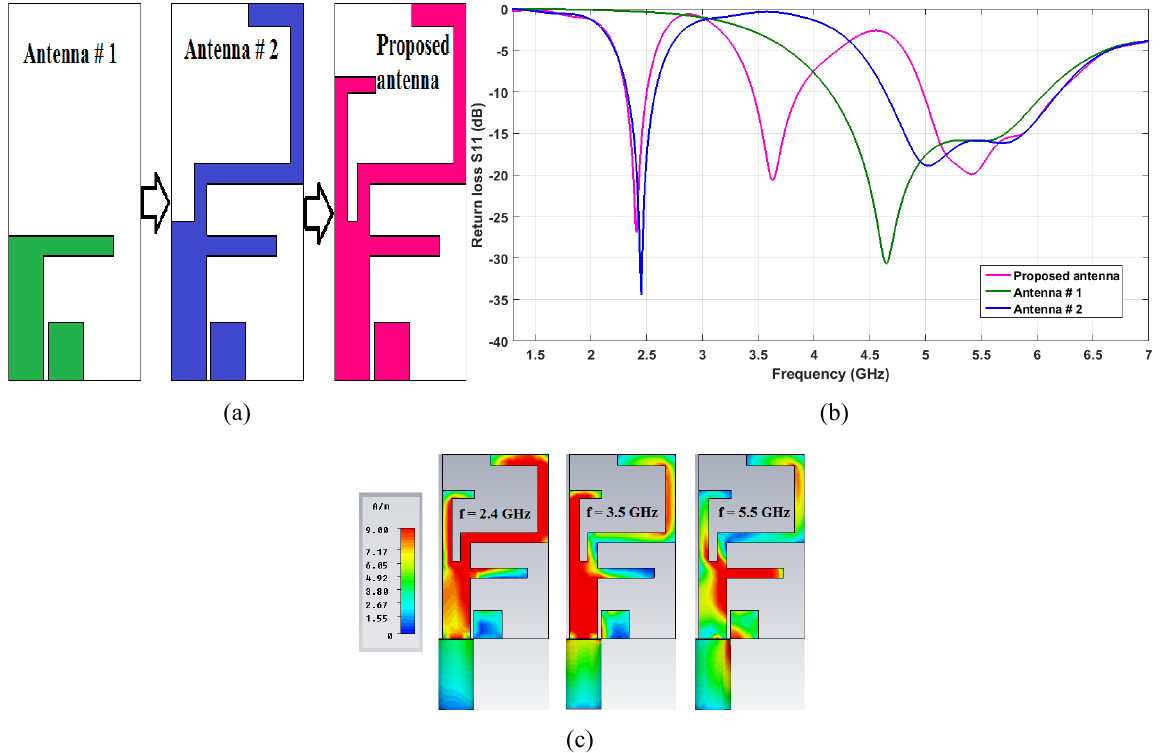
| curves (c) Surface current 11